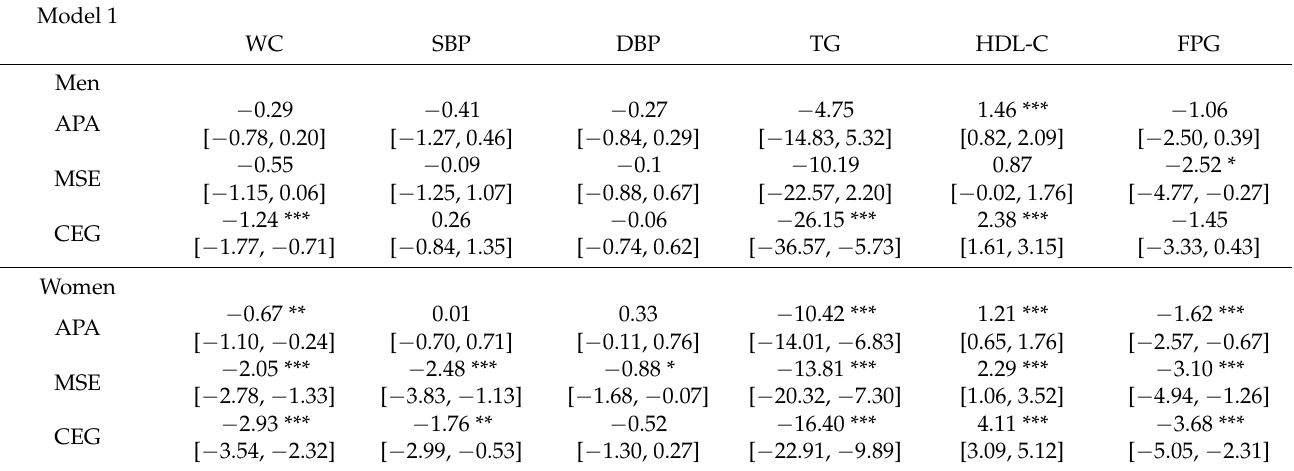
Table 4. Generalized linear model of each exercise group on metabolic components (reference: